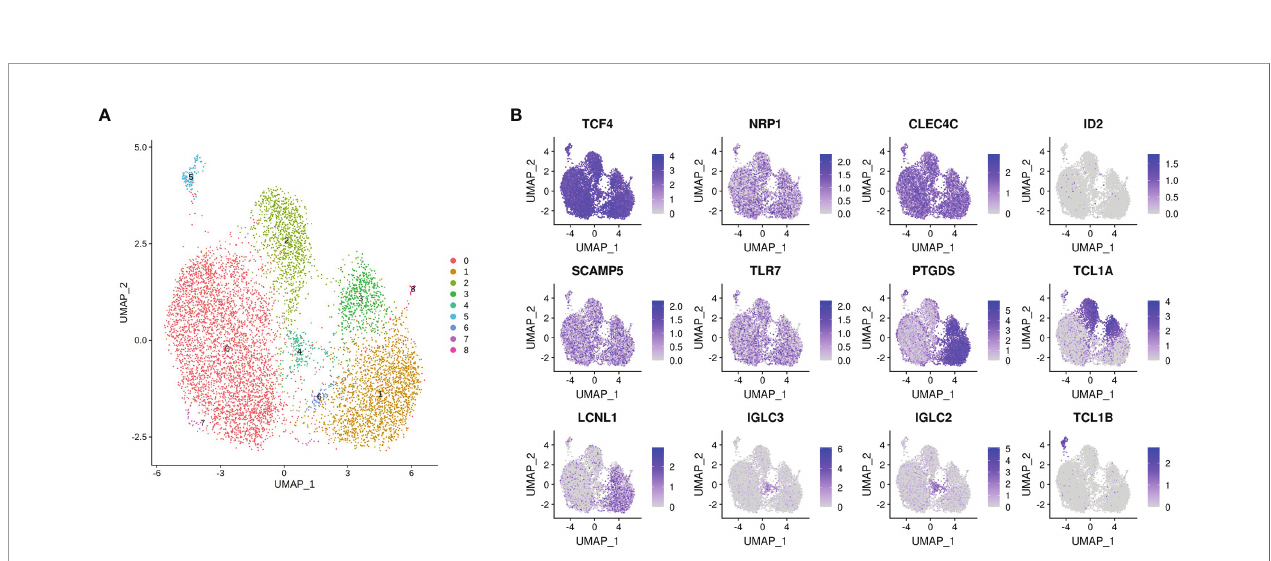
FIGURE 6 | pDC heterogeneity at baseline. (A) Cluster 0 (as identi fi ed in Figure 2B ) is further divided into 9 subclusters by Seurat, highlighting preexisting pDC heterogeneity as the cells are isolated ex vivo . (B) TCF4, NRP1 and CLEC4C are evenly distributed within these subclusters, as expected. ID2 is absent. pDC enriched genes SCAMP5 and TLR7 are also uniformly expressed, whereas PTGDS, TCL1A, LCLN1, IGLC3, IGLC2 and TCL1B distinguish various